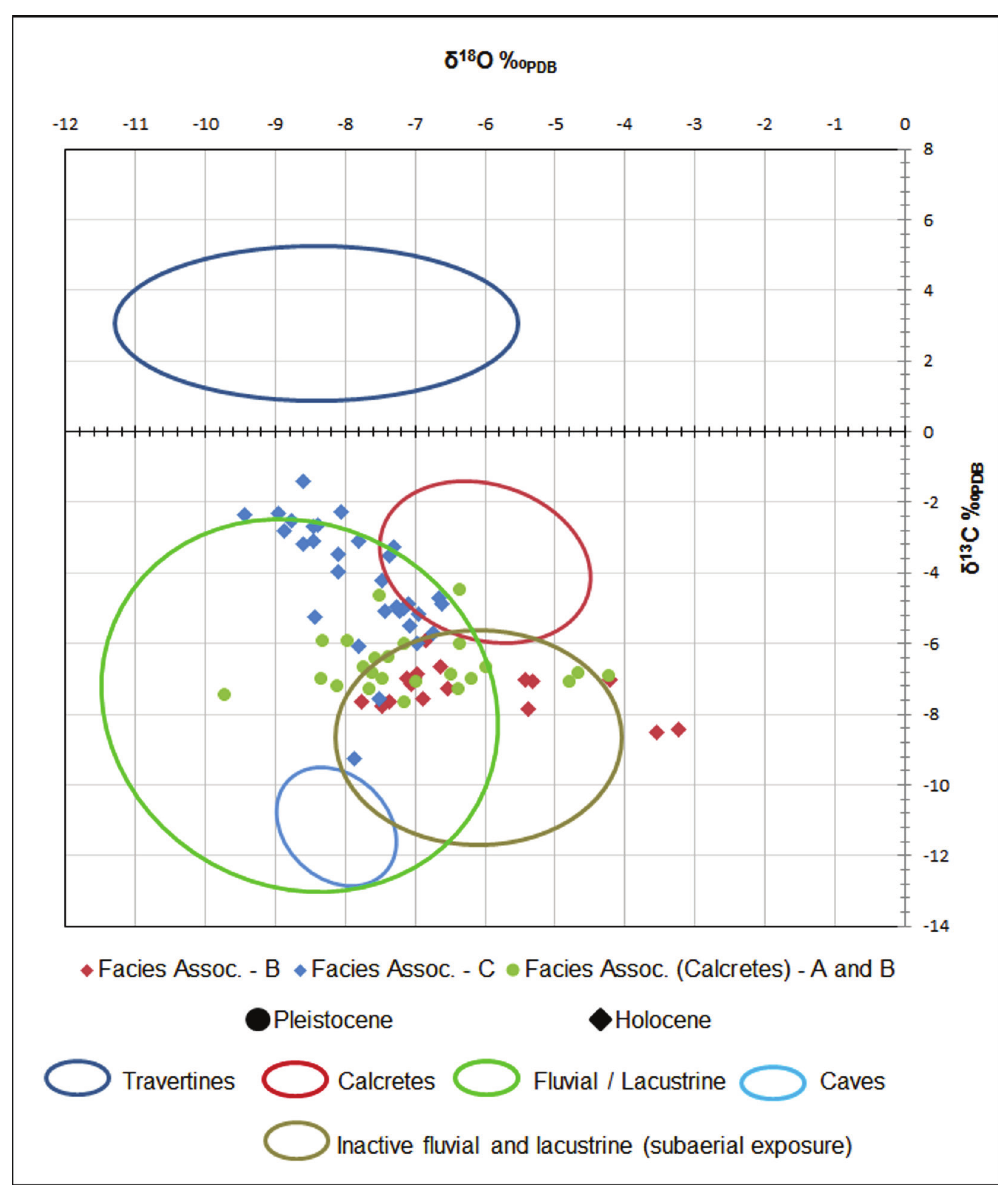
Figure 5 - Isotopic composition (δ 13 C and δ 18 O) of different facies associations and combined plot of δ 13 C and δ 18 O data from other continental carbonates. Data sources: Andrews et al. 1997, 2000, Arenas et al. 2004, Boggiani et al. 1999, Buccino et al. 1978, Chafetz and Lawrence 1994, Fritz 1965, Horvatinčić et al. 2003, Sinha et al.